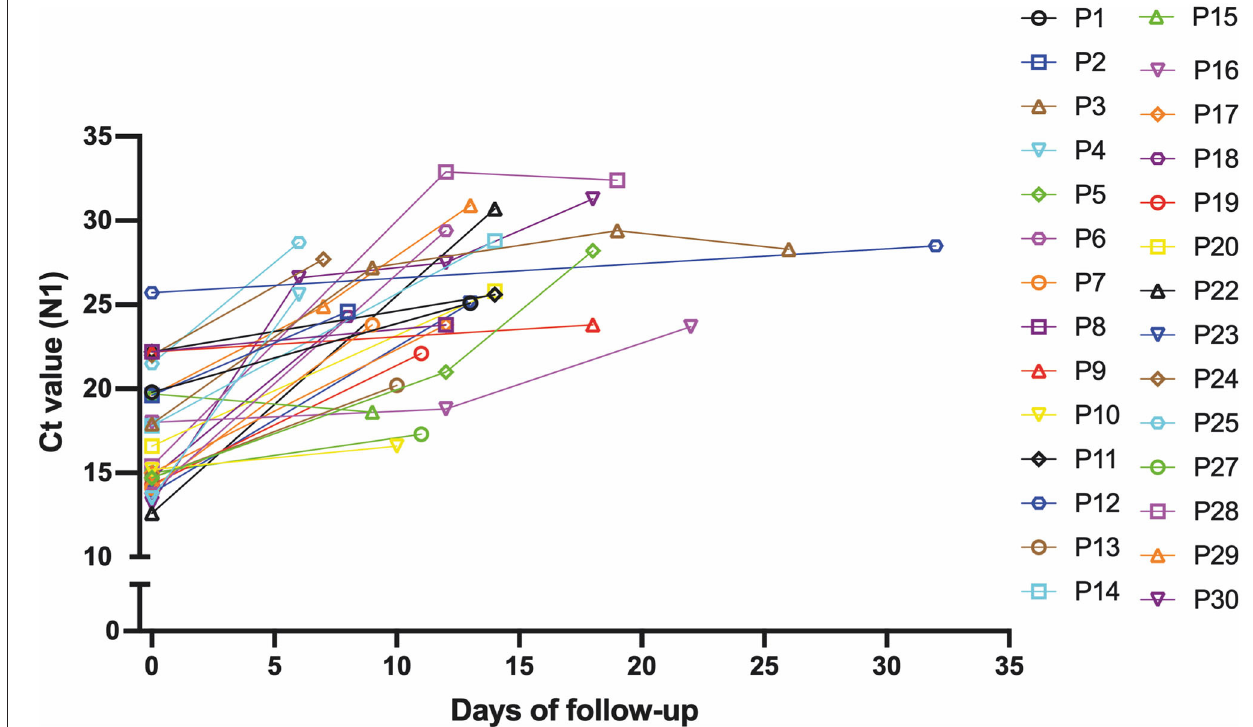
FIGURE 6 | C t values increase with prolonged infectious periods in follow-up samples. Graphical representation of the C t value from the 30 patients that comprised the follow-up dataset at the first sample collection and the following samples from these individuals during the follow-up.